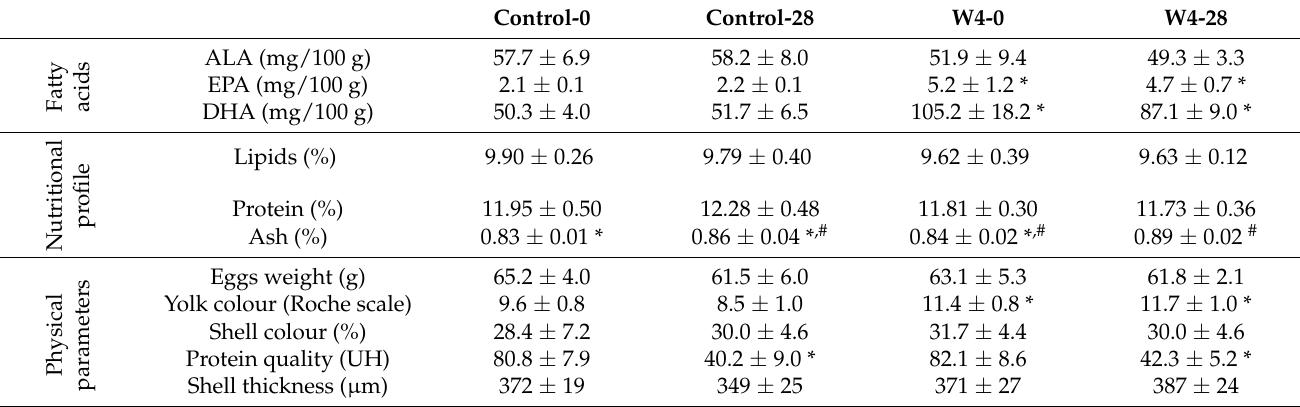
Table 3. Comparison of fatty acids contents, nutritional profile and physical parameters of control eggs those from hens fed with a supplemented diet (W4), at zero (0) and 28 days of storage. Control-0